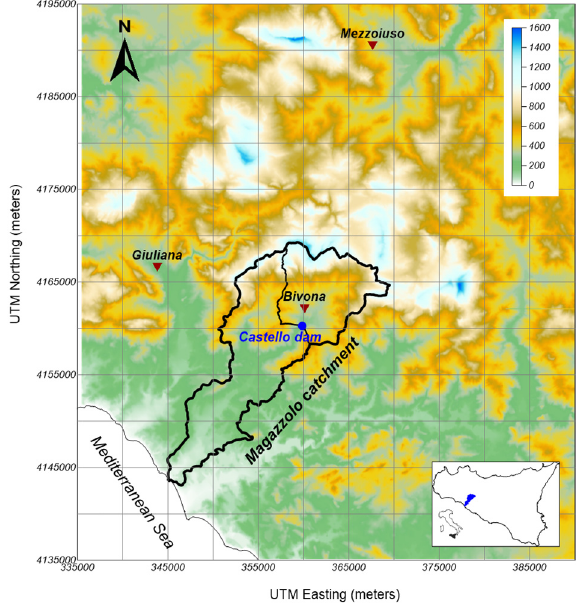
Figure 1. Magazzolo River catchment.